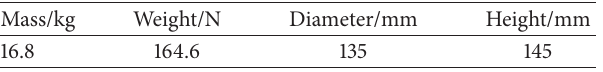
Table 1: The parameters of the drop